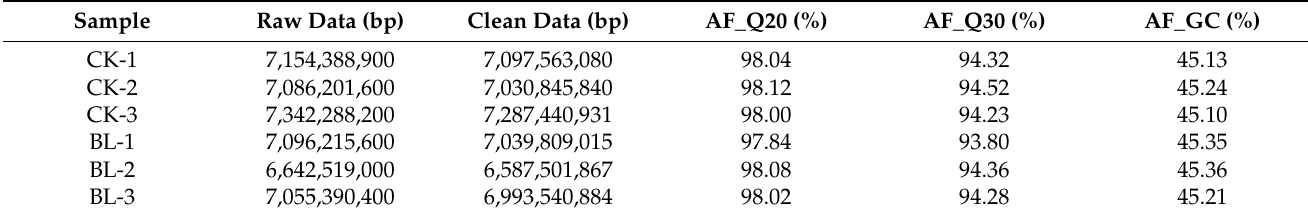
Table 1. Analysis table of base mass.